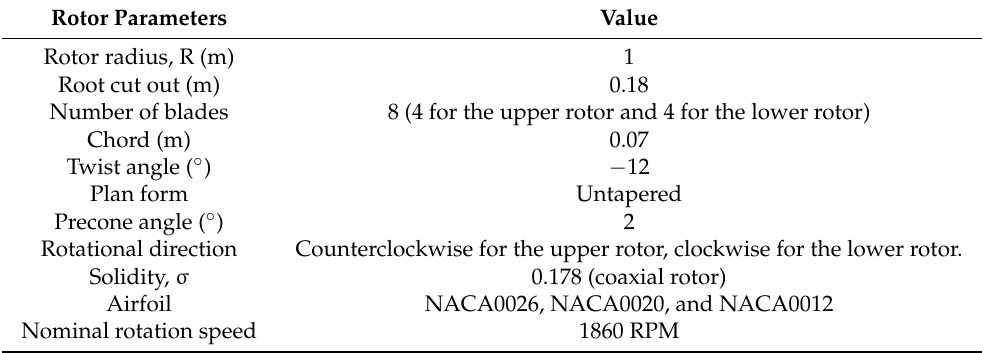
Table 2. Rotor parameters.